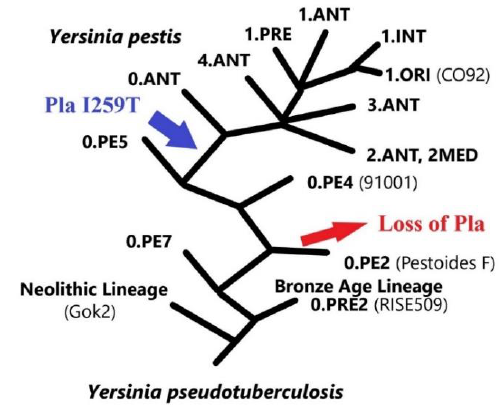
Figure 6. Genomic tree and divergence based on 503 Y. pestis Genome Assembly and Annotation reports (https: // www.ncbi.nlm.nih.gov / genome / browse / #! / prokaryotes / 153 / ). Both the modern